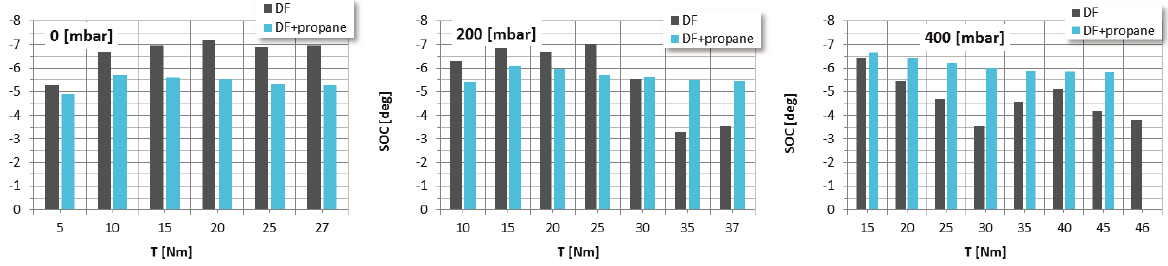
Fig. 11. Load characteristics of crank angle position at the start of combustion (C.A., BTDC) for both investigated engine operating modes Analysis of maximum combustion pressure courses